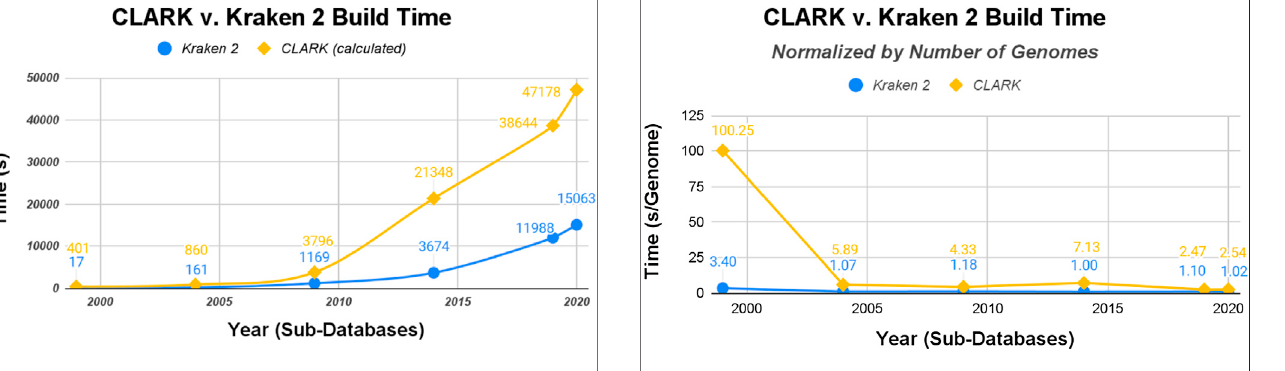
FIGURE 3 | CLARK and Kraken 2 raw Build Time (seconds).